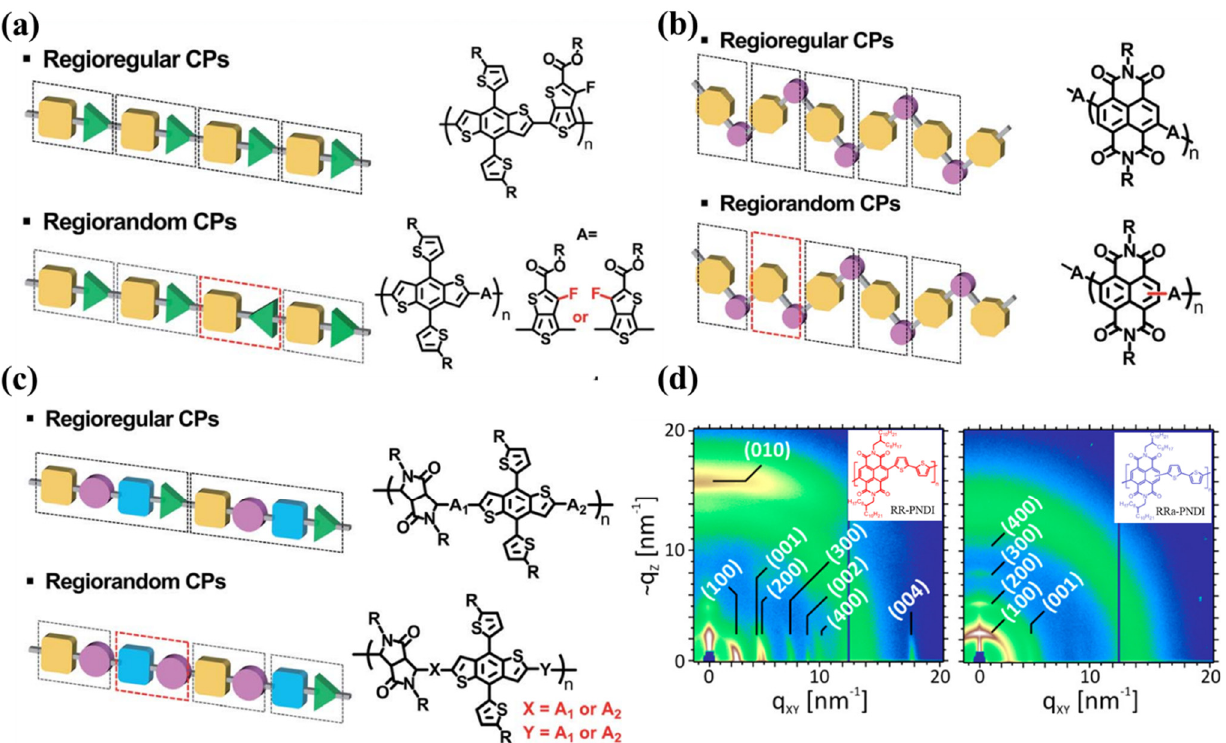
Figure 2. Schematic diagrams and structural representations of ( a ) directional, ( b ) positional, and ( c ) sequential RRs of D-A conjugated polymers that were adapted from reference [48] with permission from Copyright 2022 Royal Society of Chemistry. (d) Plots of 2D GIXD detector intensities for annealed PNDI films spin-coated from CB solutions that were adapted from reference [54] with permission from Copyright 2014 American Chemical Society.